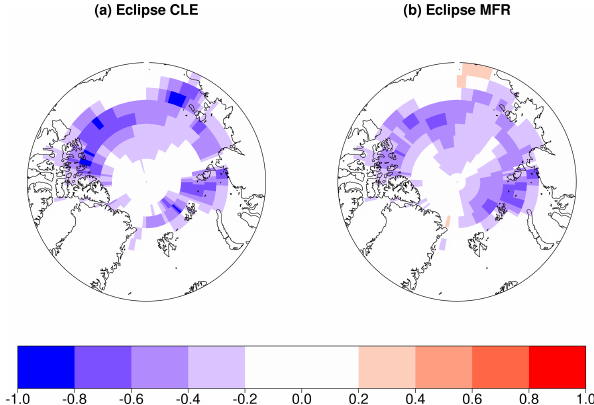
Figure 12. Spatial distribution of the statistically significant September Arctic sea-ice fraction change between the 1990–2010 mean and the 2030–2050 mean as calculated by the GISS-E2.1 Eclipse ensemble (CMIP6 ensemble is not shown due to statisti- cally insignificant changes calculated by the Student t